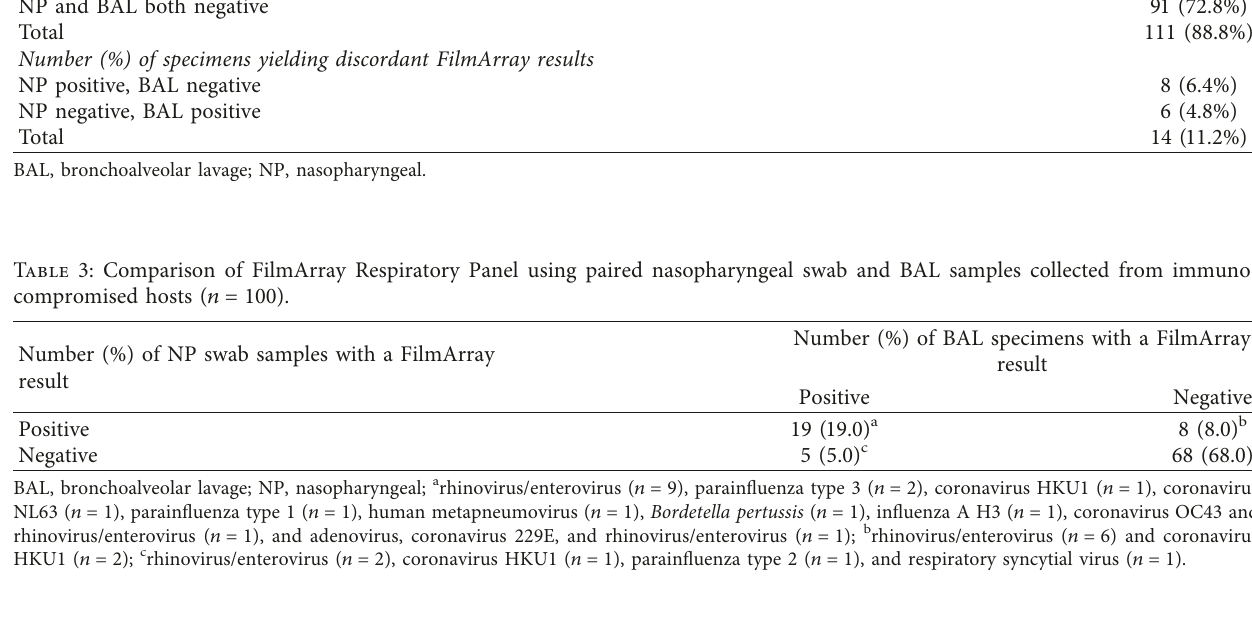
Table 2: Concordance of the FilmArray Respiratory Panel when performed on paired NP swabs and BAL fluid specimens ( n � 125). Number (%) of specimens yielding concordant FilmArray results NP and BAL both positive